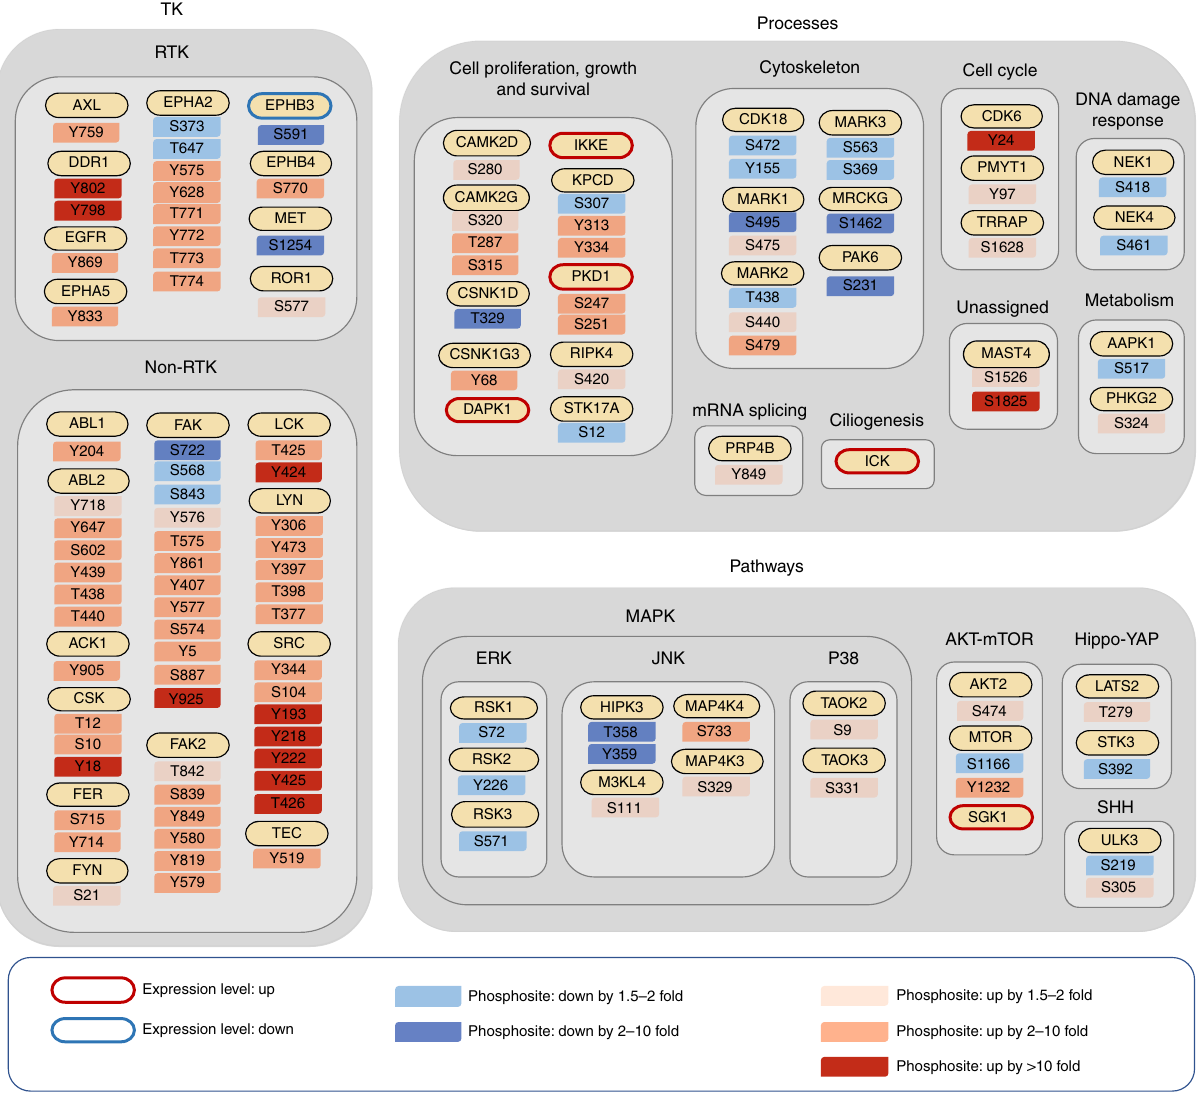
Fig. 2 Bioinformatic assignment of Src-regulated kinases. Kinases were assigned to speci fi c kinase classes, biological processes and pathways according to the information extracted from the GeneCards database and/or the literature. Expression and phosphosite regulation is as de fi ned in the legend. Fold change is expressed relative to the value for vector control cells which was arbitrarily set at 1. Up or down means levels were increased or decreased